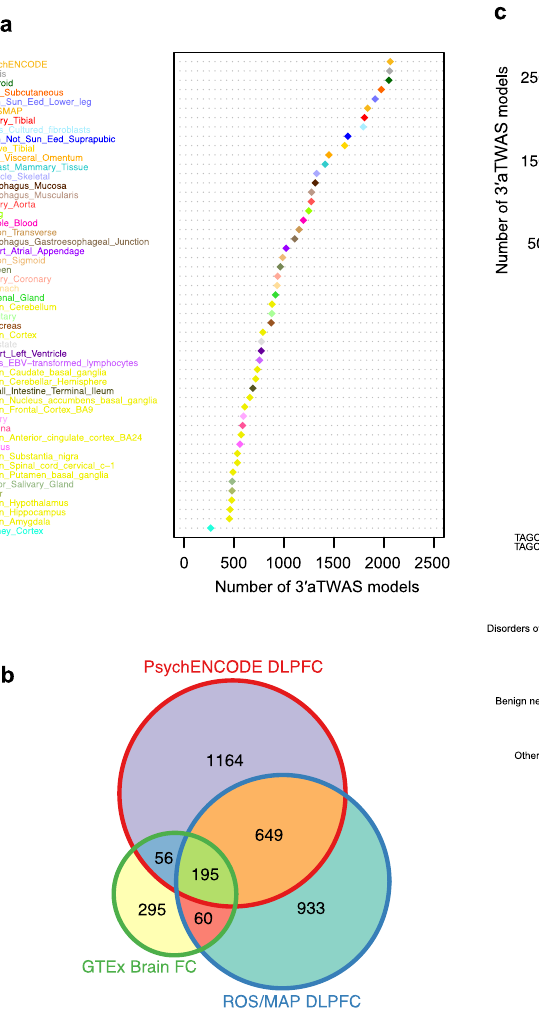
sample size in each tissue. Each dot indicates a tissue type. Yellow and gray dots indicate brain and non-brain tissue types, respectively. d A majority of human diseases of 3 ′ aTWAS genes are not expression TWAS or splicing TWAS genes. 3 ′ aTWASspeci fi cgenesareshowninblue.Overlapbetween3 ′ aTWASandexpression TWASgenesisshowningreen.Overlapbetween3 ′ aTWASandsplicingTWASgenes is shown in